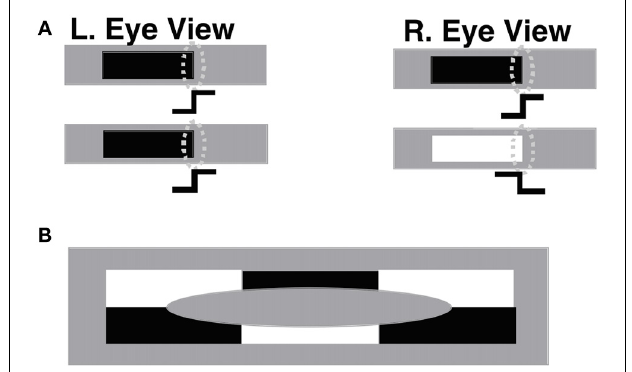
FIGURE 3 | (A) The same-sign hypothesis: only edges that have the same contrast polarity can be stereoscopically fused to produce a percept of depth. The rightmost edges in the left and right eye figures in the upper row, which have the same contrast polarity and orientation, can be binocularly fused if their corresponding simple cells (oval shapes) input to complex cells with an appropriate disparity sensitivity. The rightmost edges in the left and right eye figures in the lower row, having opposite contrast polarities, cannot be binocularly fused. (B) Individual complex cells receive inputs from simple cells that respond to both dark-light and light-dark contrast polarities, as well as to both red-green and green-red, and blue-yellow and yellow-blue contrasts. As a result, complex cells can respond in a contrast-invariant way along the boundary of a figure whose contrast polarity reverses as the boundary is traversed. In particular, complex cells can respond at every position along the boundary of the depicted ellipse, even though the contrast polarity reverses relative to the background as its perimeter is traversed. Reproduced with permission from Cao and Grossberg